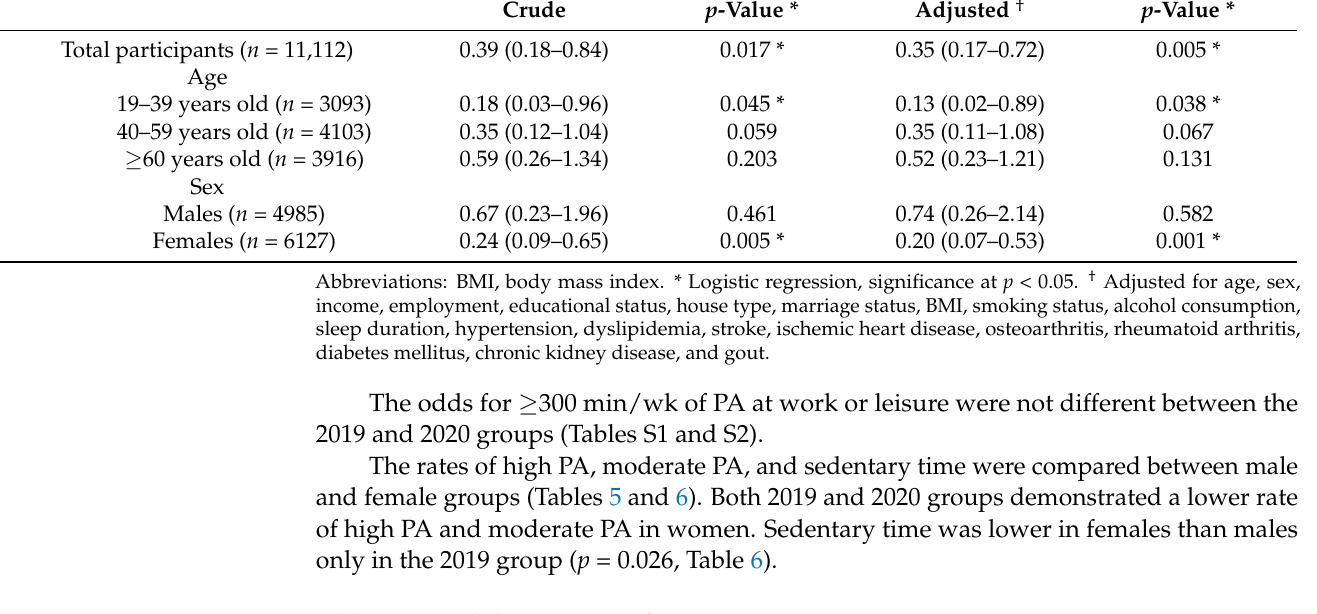
Table 5. General characteristics of